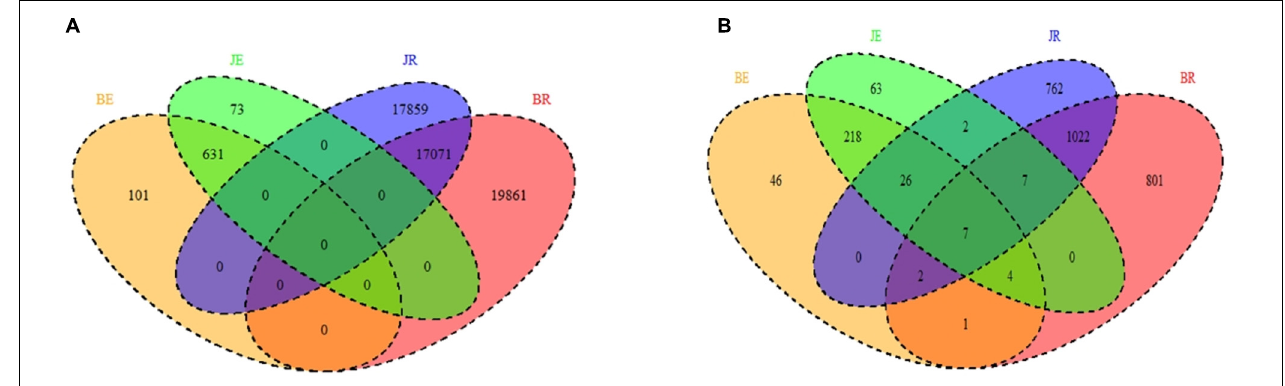
FIGURE 3 | Venn diagram showing the unique and shared OTUs (3% distance level) ( A bacteria; B fungi) in the rhizosphere soil and root of cotton by different niche and pathological statuses (endophytic diseased, endophytic healthy, rhizosphere diseased, and rhizosphere healthy, respectively). BE, JE, BR, and JR represent endophytic diseased, endophytic healthy, rhizosphere diseased, and rhizosphere healthy, respectively.